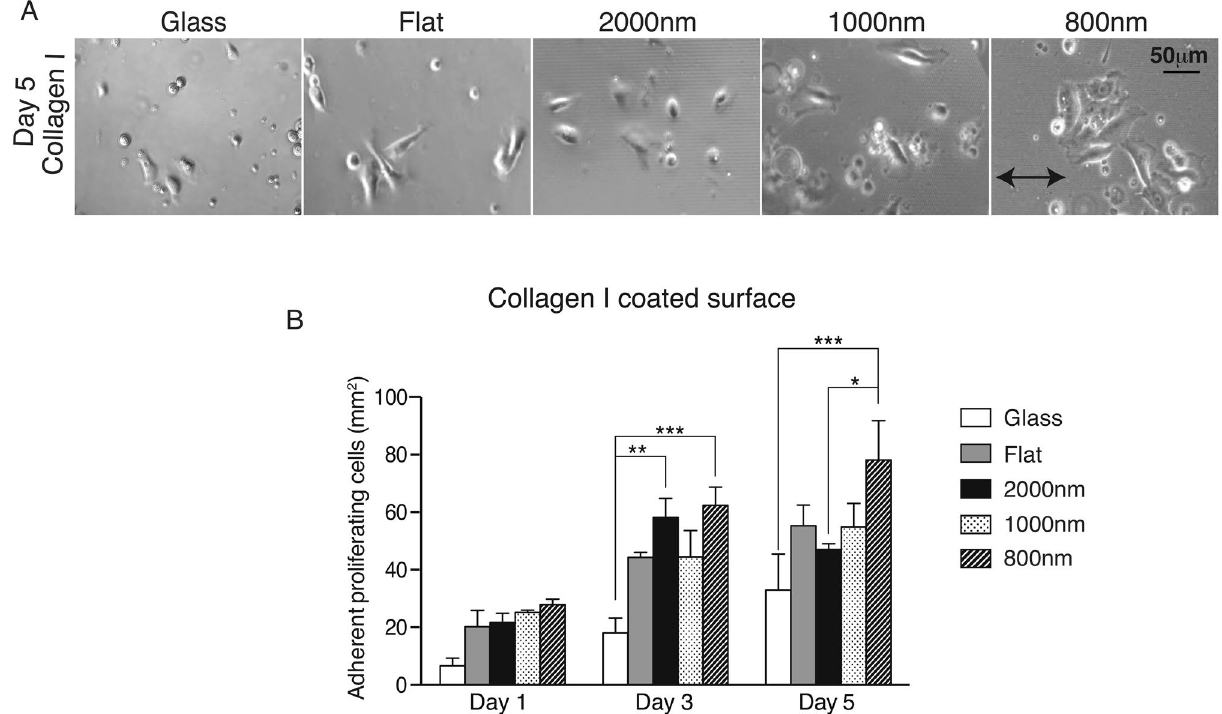
2000 nm, 1000 nm and 800 nm ridge width pattern. Phase-contrast images were taken at 5-day time point. ( B ) Quantification of cell number demonstrated that collagen I coating improved cell spreading and growth when compared to previous experiments. Silk films were better than glass and the smallest ridge width 800 nm showed the highest cell number (* indicates p < 0.05, ** indicates p < 0.005, ***indicates p < 0.0005. Values are means ± S.E.M. The arrow indicates the direction of pattern